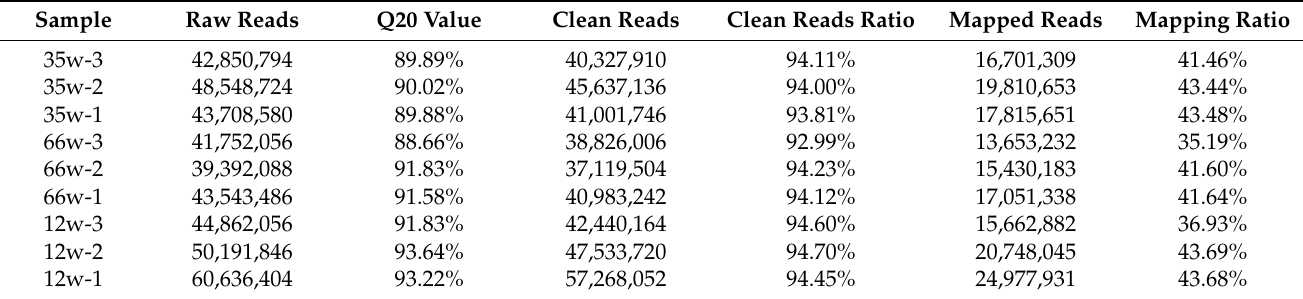
Table 1. Statistical information of RNA-seq data in each